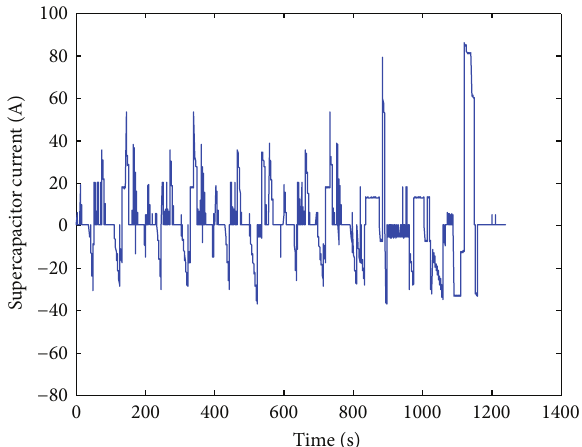
Figure 27: Supercapacitor current.